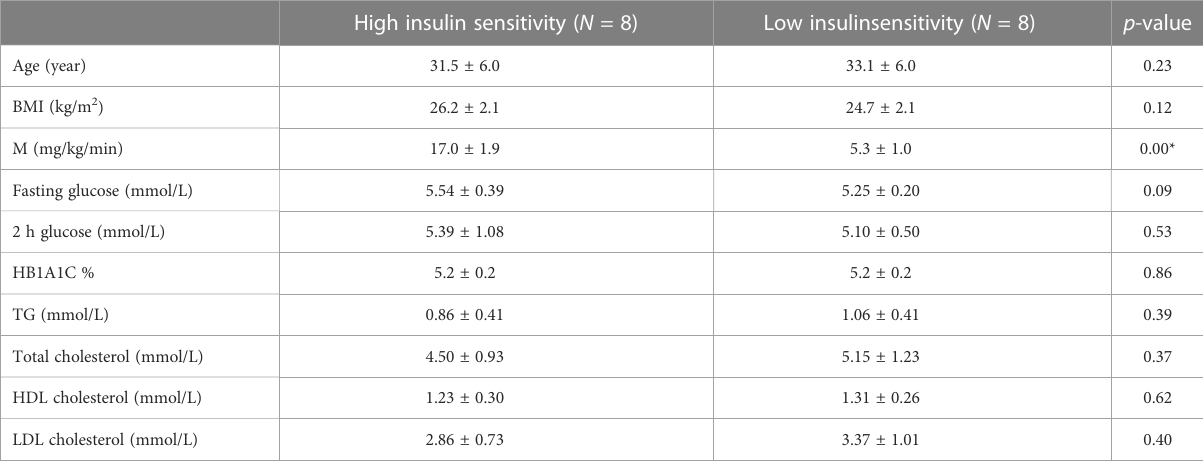
TABLE 1 Anthropometric and metabolic characteristics of the subjects with low insulin sensitivity (LIS) and high insulin sensitivity